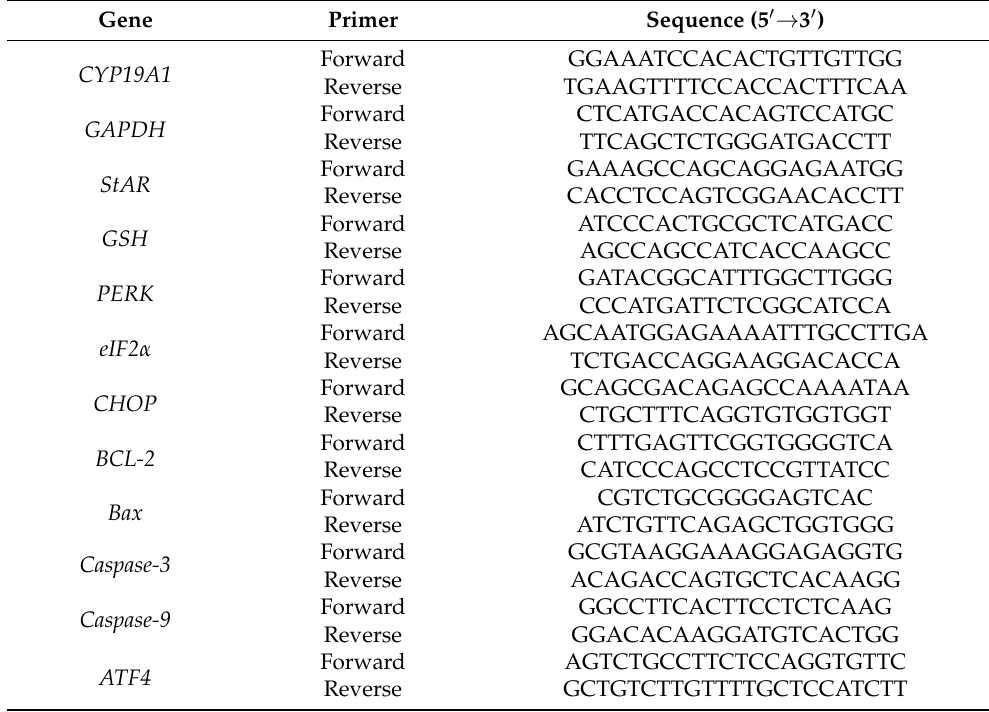
Table 1. Primers used for a quantitative real-time polymerase chain